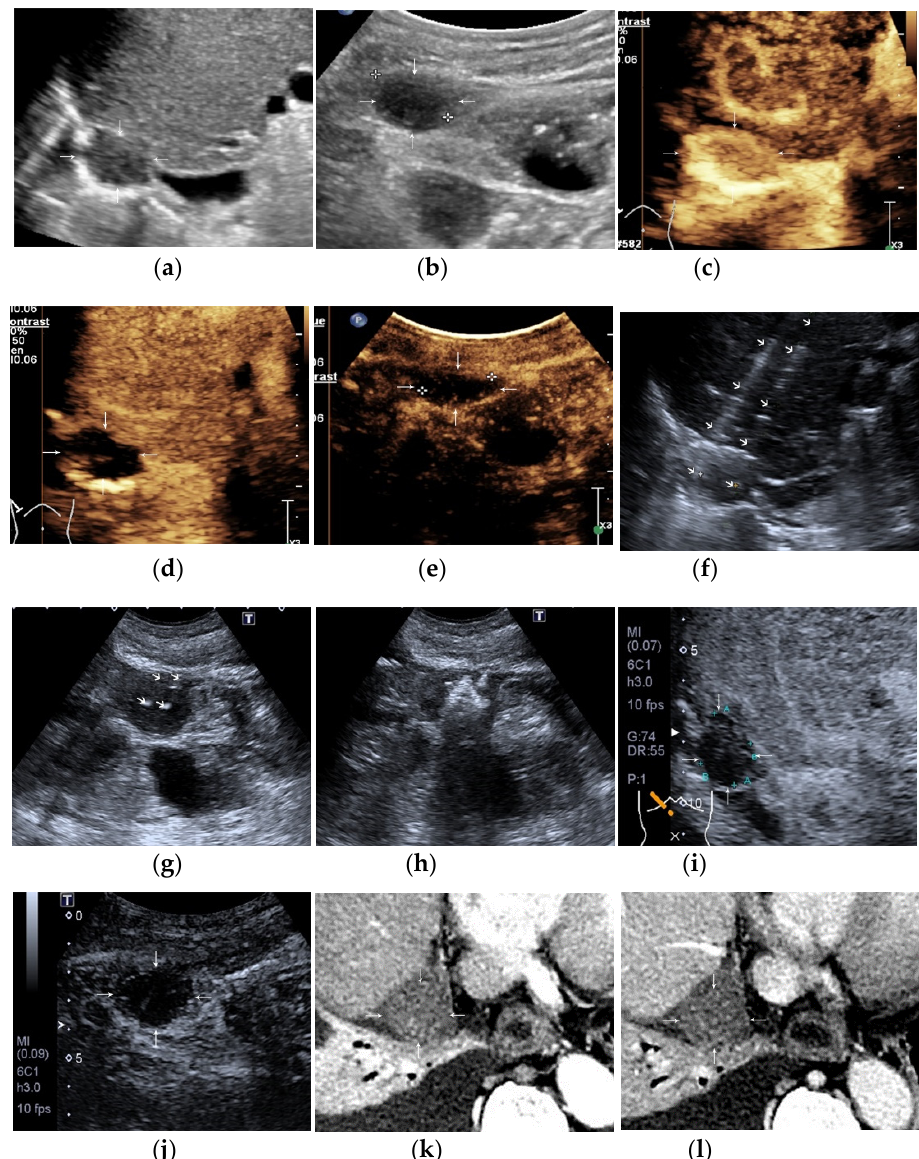
Figure 1. A 65-year old male had hepatocellular carcinoma (HCC) and was diagnosed with extrahepatic metastases to abdominal lymph nodes. US-guided laser ablation (LA) was performed. ( a , b ) A hypoechoic lymph node inferior to the right diaphragm ( a ) and right paracolon ( b ) were detected by the grayscale ultrasound. ( c – e ) On the contrast-enhanced ultrasound (CEUS) images, the targeted lymph node displayed heterogeneous hyperenhancement in the early phase (c) and washout in the late phase ( d , e ). ( f , g ) With the guidance of real-time US, optic fibers were inserted into the target lesions precisely and the tips of the fibers clearly seen. ( h ) Hyperechoic zone around the fiber tip appeared and the range extended as the procedure proceeded. ( i , j ) One month later, the target lymph nodes inferior to the right diaphragm ( i ) and right paracolon ( j ) showed no enhancement on the CEUS images, indicating a complete ablation. ( k , l ) One month later, target lymph node inferior to the right diaphragm exhibited no enhancement in the arterial phase ( k ) and in the portal-venous phase ( l ) on the contrast-enhanced computed tomography (CECT).